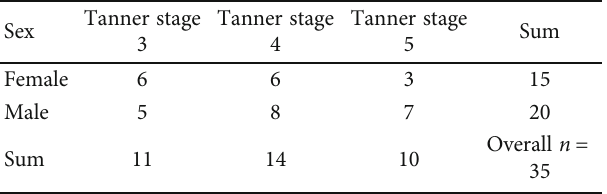
Table 2: Number of individuals by Tanner stage and